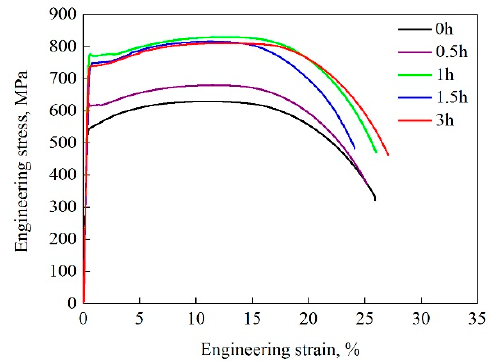
Figure 6. Tensile stress–strain curves of the steel samples subjected to different processing methods.